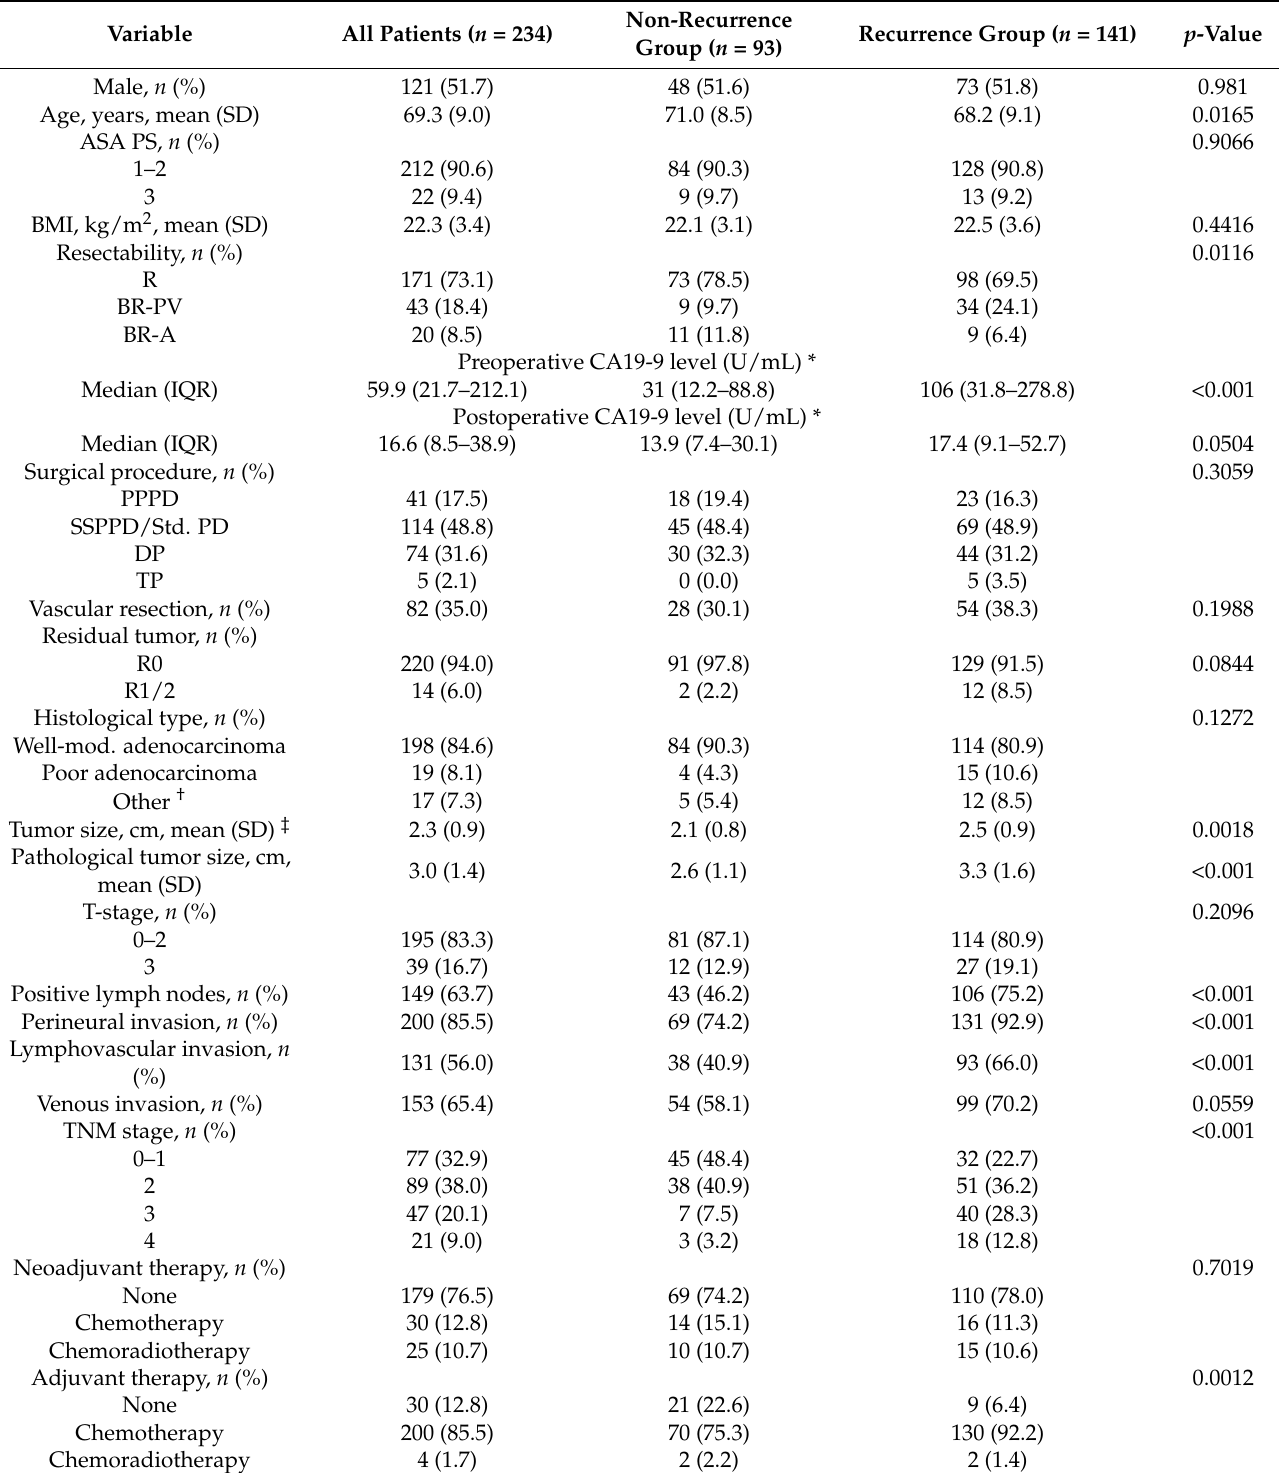
Table 1. Demographic, clinicopathological and treatment characteristics of included